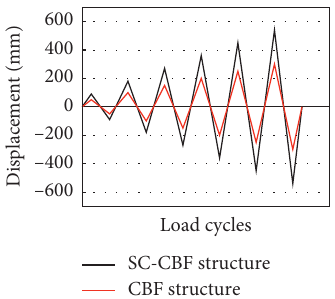
Figure 13: Cyclic loading protocol.